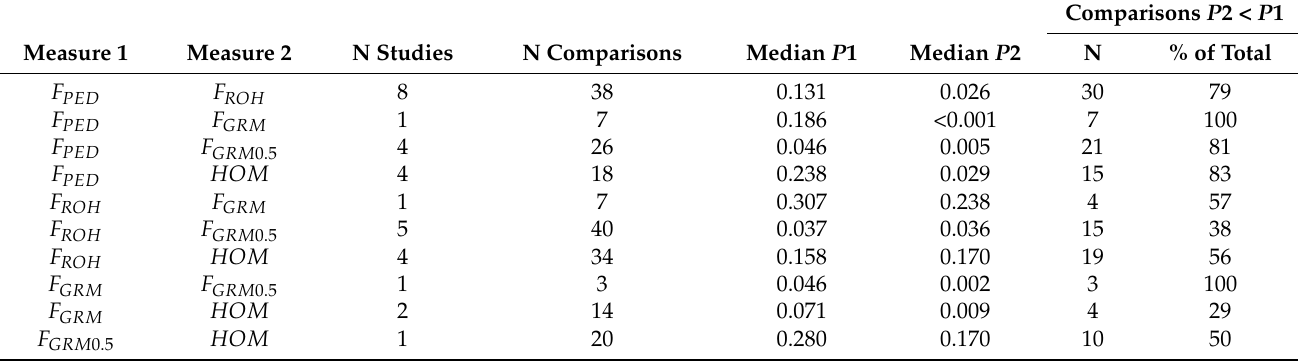
Table 2. Comparison of p -values of inbreeding depression estimates based on different pedigree-based and SNP-based inbreeding measures. Comparisons were made within studies and for each combination of two inbreeding measures, where both inbreeding measures had an unfavorable effect on the